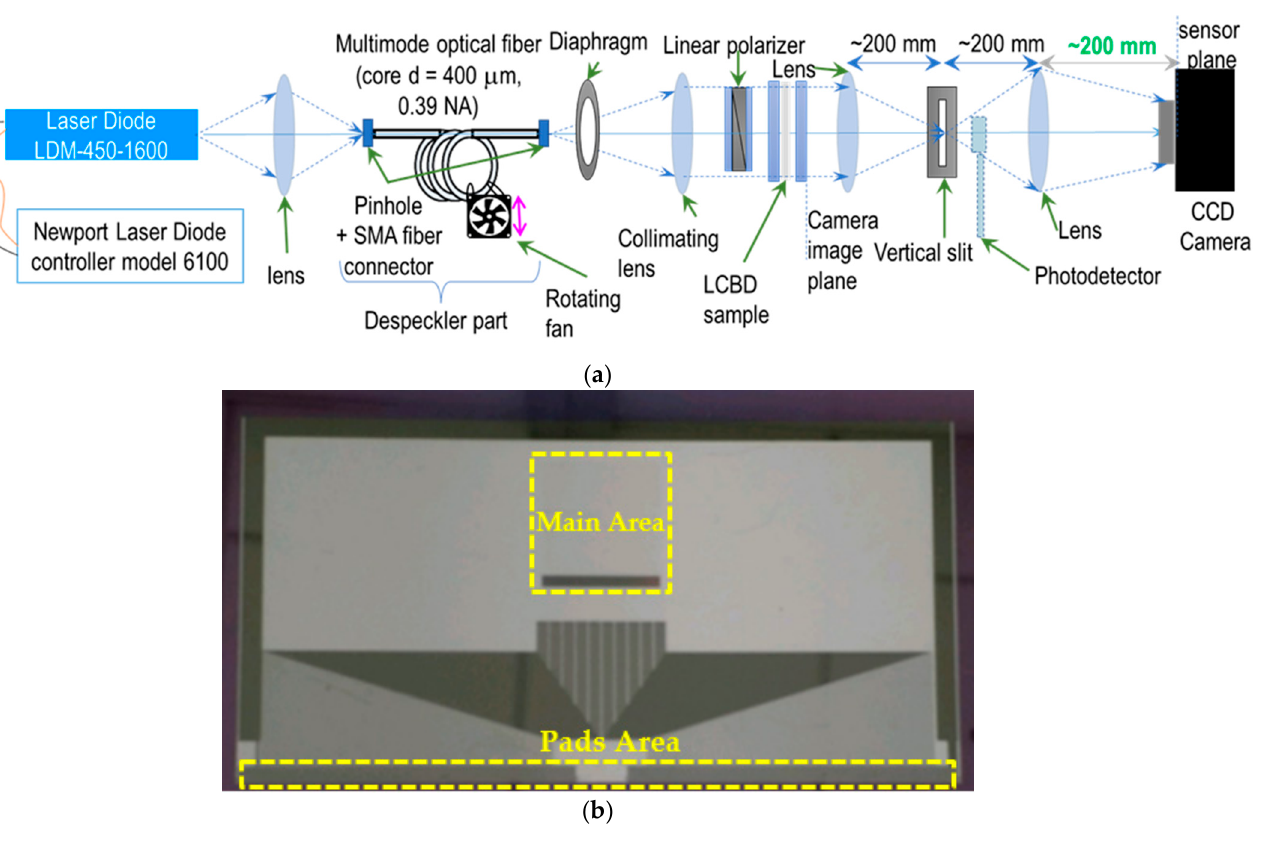
Figure 7. ( a ) The schematic diagram of components for DE measurement; ( b ) actual BD cell showing the main area containing ITO-based patterned electrodes with high birefringence of NCL and the pads area for 720-channel driver IC.